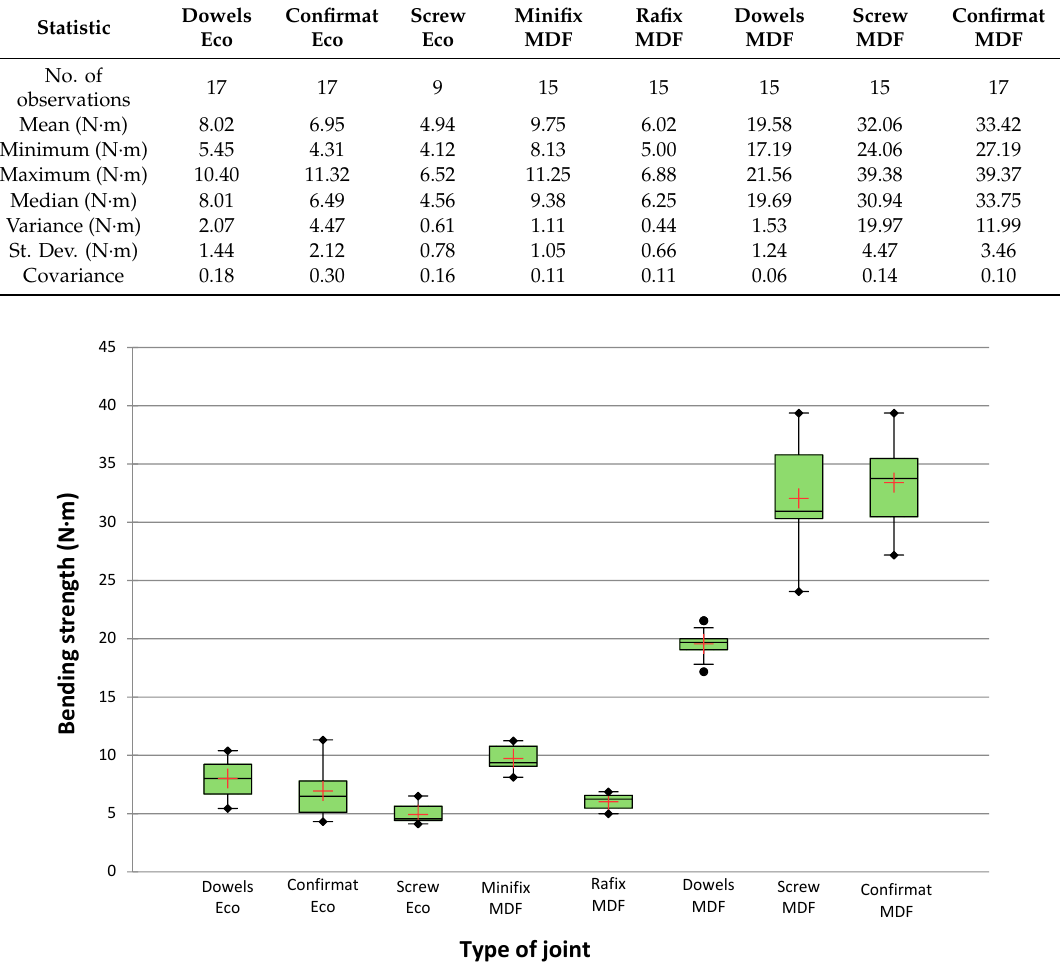
Figure 5. Bending strength under the compression test of L-type corner joints, which were constructed from eco-friendly composites and MDF.